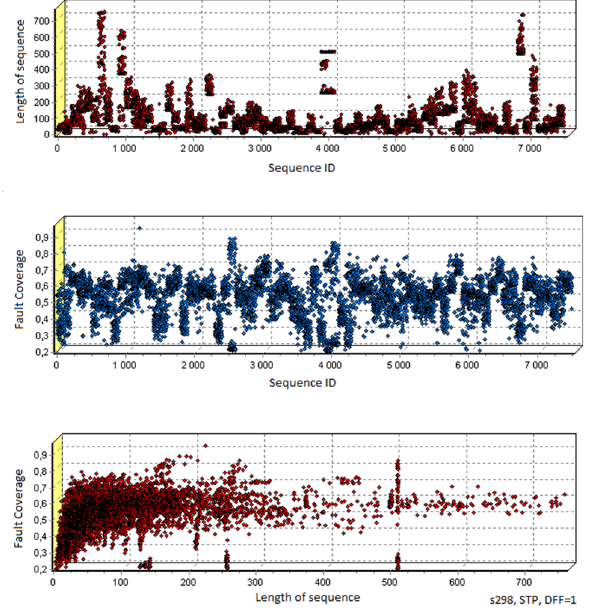
Fig. 22 STP for s298 with use of 1 internal flip-flop